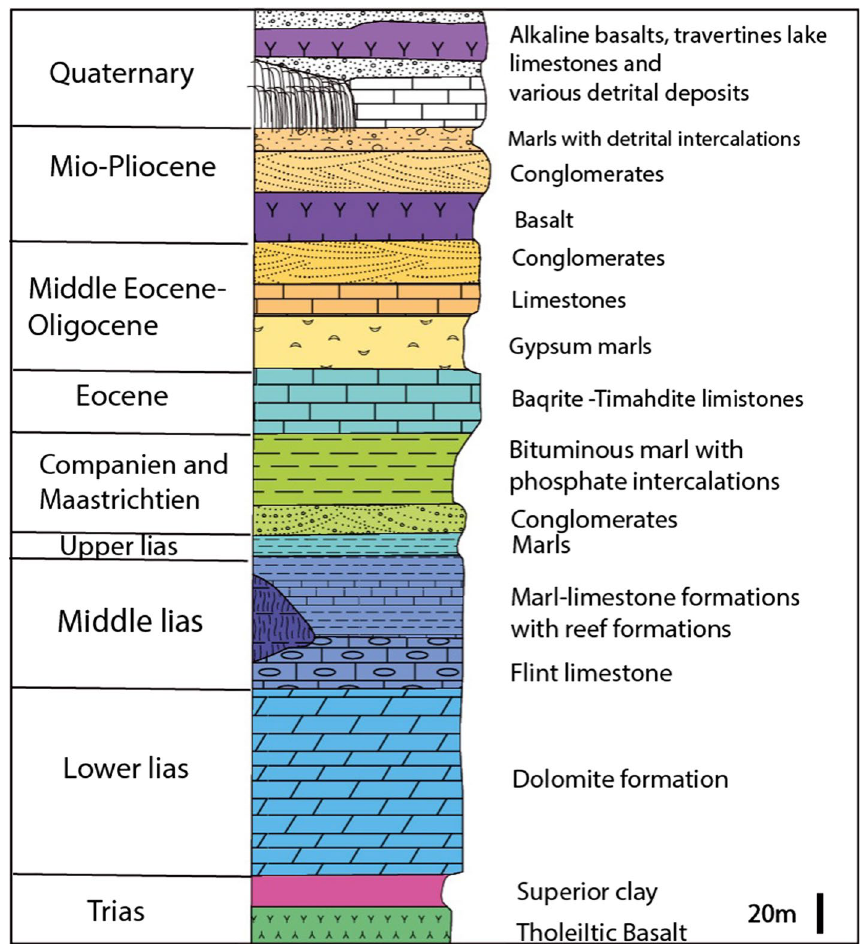
Fig. 2 Synthetic